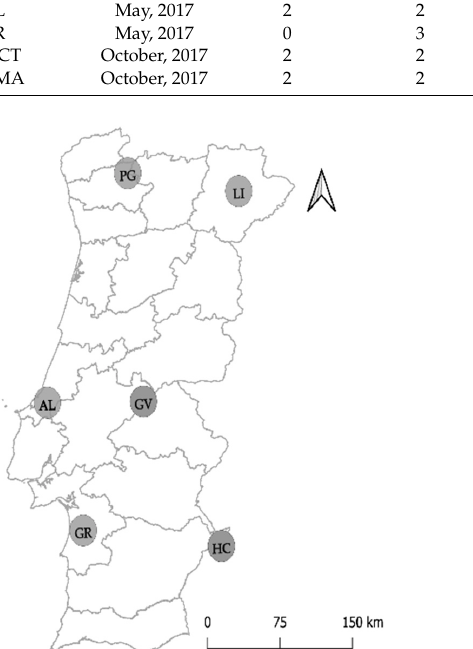
Figure 1. Distribution of cork oak stands sampled in Portugal. Letters represent sampled location